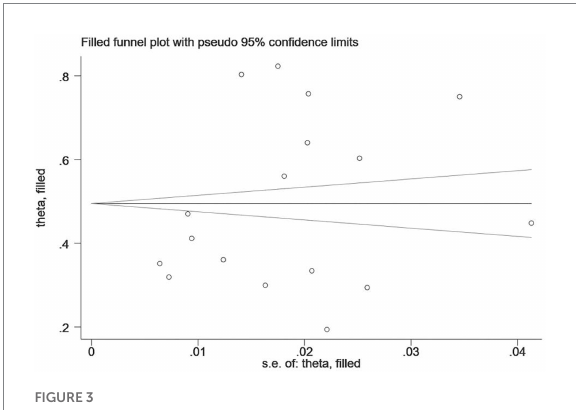
FIGURE 3 A funnel plot assessing publication bias of the prevalence of depression among remote learning students during the COVID-19 pandemic.